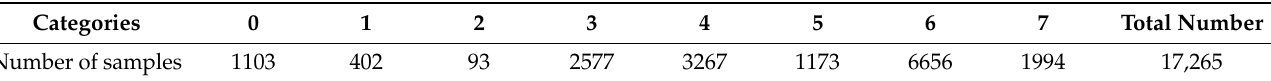
Table 4. Statistics of the number of sample condition categories.